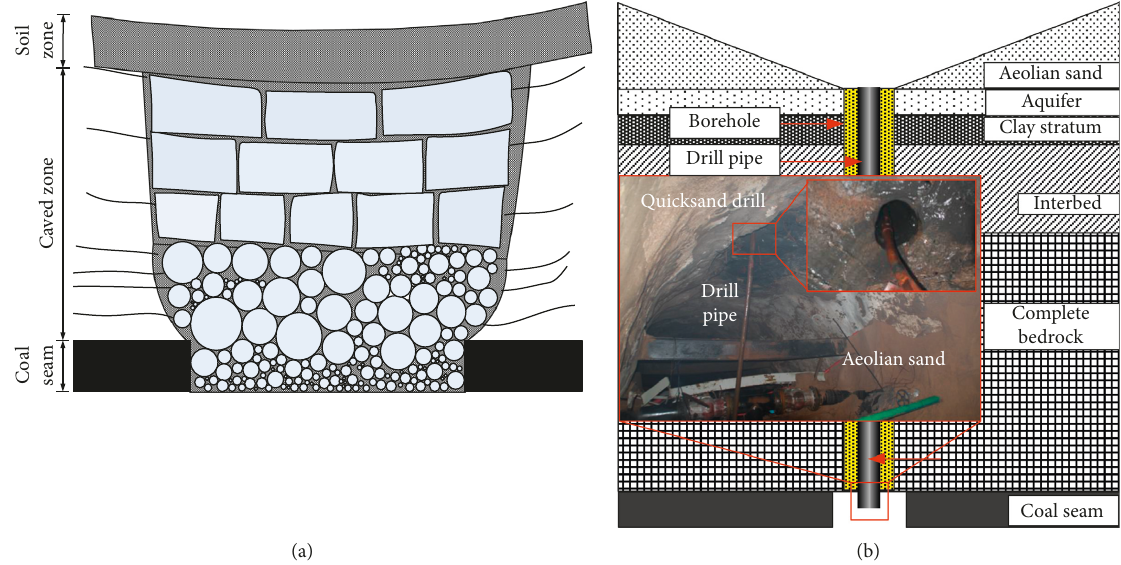
Figure 1: Quicksand disaster schematic diagram. (a) Quicksand trip through overburden strata above a longwall panel [12, 13]. (b) Quicksand trip through